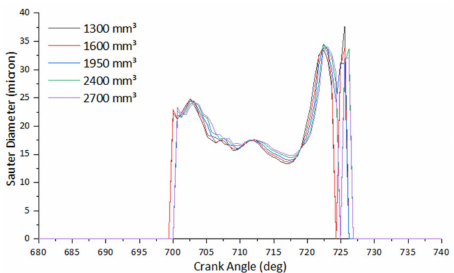
Figure 15. Fuel SMD under varied valve